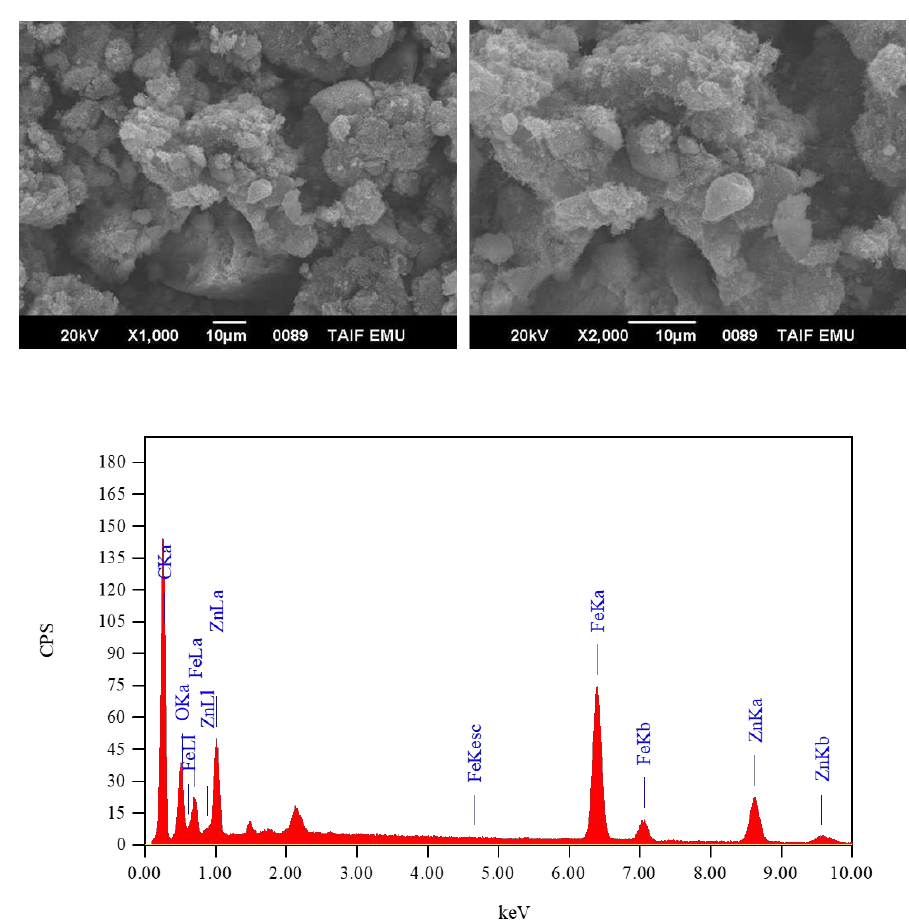
Figure 9. SEM micrographs and EDX spectrum of the ZnFe 2 O 4 -CNT adsorbent.